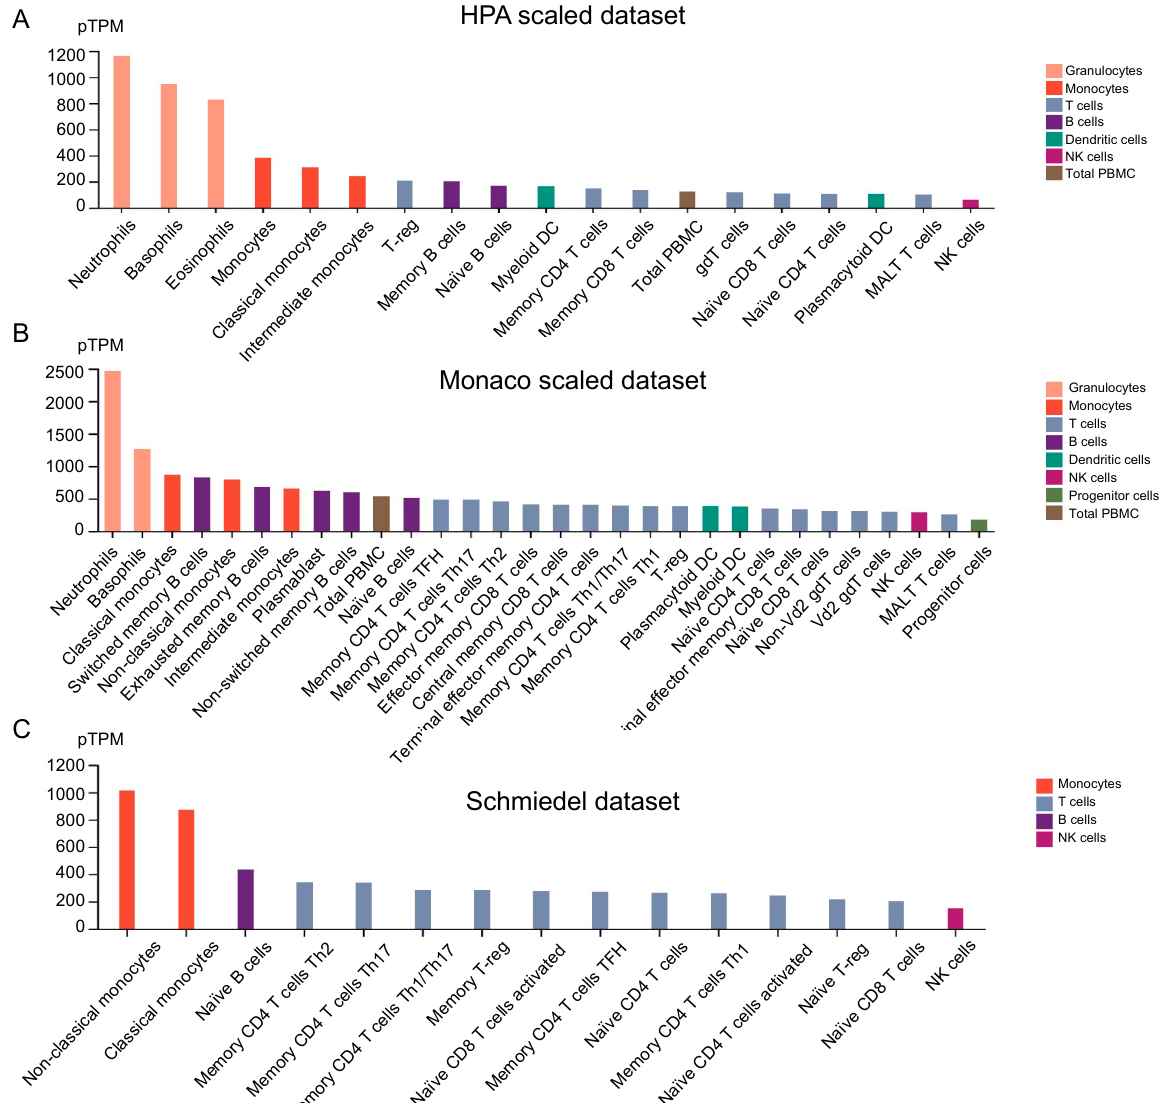
Figure 6. Protein expression level of EVI2B in different immune cells from HPA. ( A ) Protein expression level of EVI2B in the HPA scaled dataset. ( B ) Protein expression level of EVI2B in the Monaco scaled dataset. ( C ) Protein expression level of EVI2B in the Schmiedel dataset.